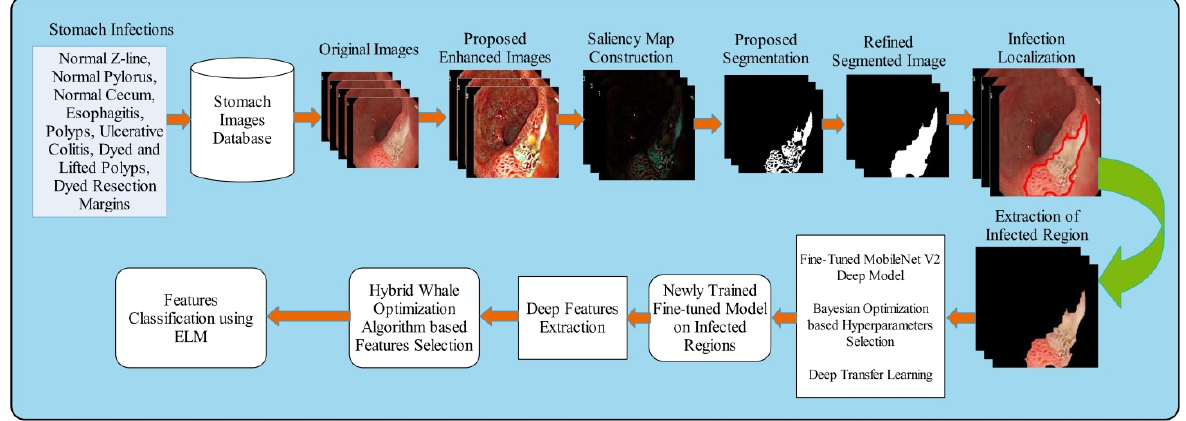
Figure 1. Proposed saliency estimation and deep learning framework for GIT diseases classifica- tion.